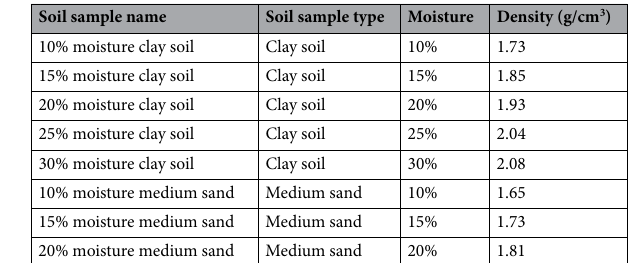
Table 1. Test the material properties of the soil